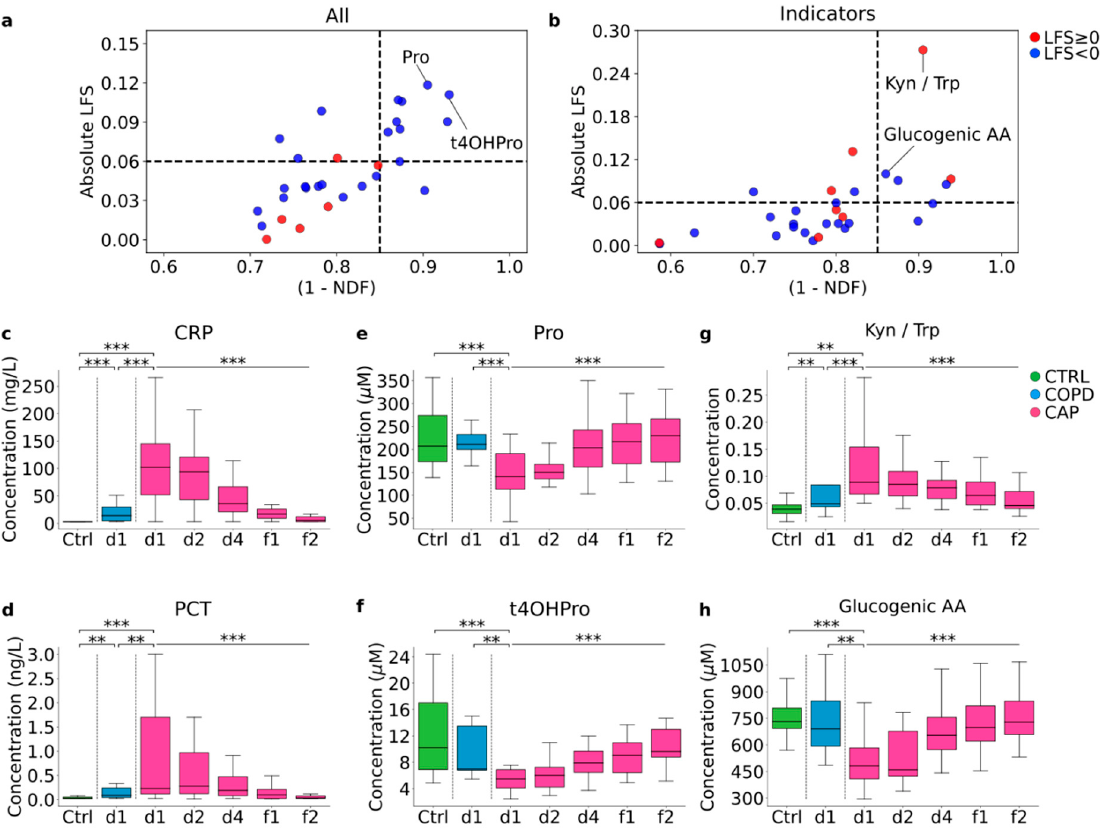
Figure 5. Selection of biomarkers that correlate with resolution of CAP. Amino acids and amino acid metabolites ( a ) and metabolism indicators ( b ) that correlate best with resolution of CAP were identified using a plot of linear fitting slope ( y − axis, LFS) vs. 1 − normalized distance to fitting ( x -axis, NDF). ( c – h ) Dynamics of change throughout the time course: CRP ( c ) , PCT ( d ) , the two best correlating amino acids/amino acid metabolites (proline ( e ), 4OH-proline ( f )), and the two best correlating metabolism indicators, Kyn/Trp ratio ( g ) and glucogenic amino acids ( h ). ** p < 0.01, and *** p < 0.001 (Mann–Whitney U test for paired comparisons, Kruskal–Wallis H-test for CAP d1 through CAP f2). AA—amino acids.